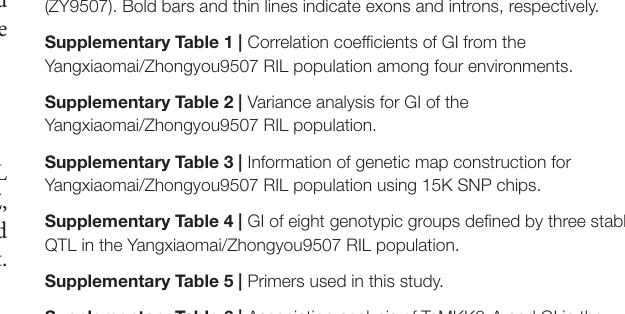
Supplementary Table 5 | Primers used in this study.